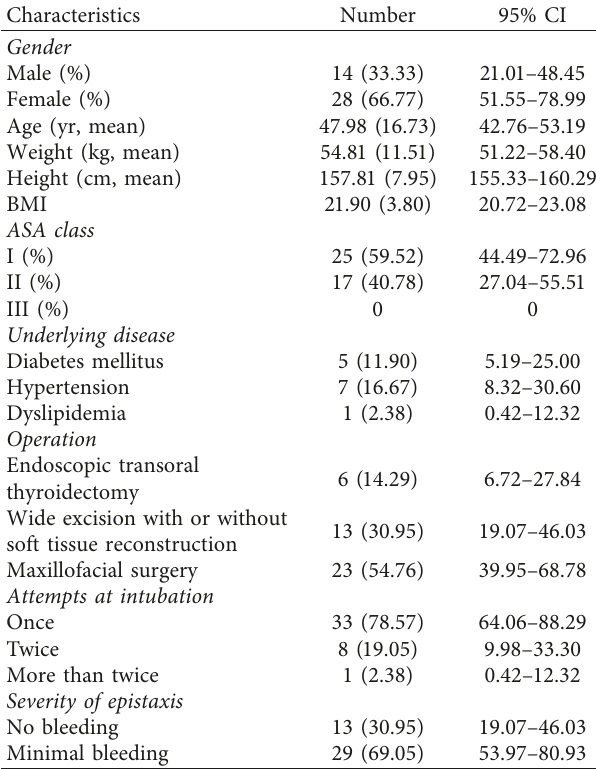
Table 1: Demographic